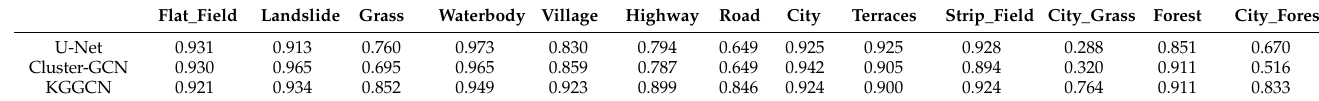
Table 2. The pixel-based accuracies of the three models in segmentation for all